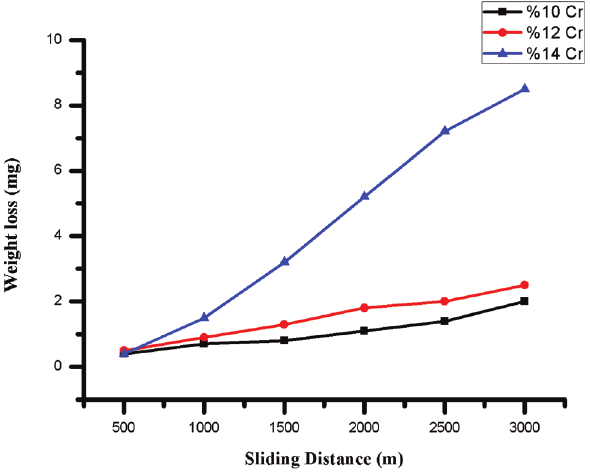
Fig. 7: The friction coefficients of samples worn at a sliding distance of 3000 m and under a load of 120